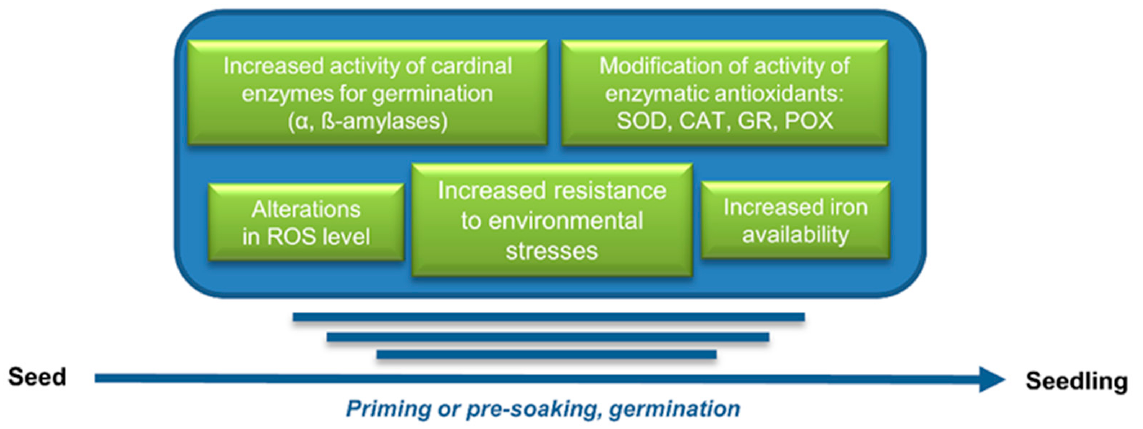
Figure 3. NO (mostly SNP)-induced changes observed after seed priming or seed presoaking resulting in stimulation of seed germination and enhancement of seedling growth under unfavourable environmental conditions. The order of incidents shown in the figure does not reflect the actual sequence of events.